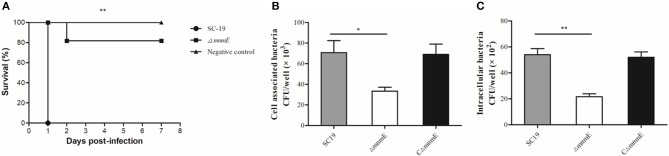
MnmE contributes to SS2 pathogenicity in vivo and in vitro. (A) Survival curves for mice in experiment infection. Ten mice in each group were separately injected intraperitoneally with 3 × 109 CFU/mice of SC19 and ΔmnmE. Ten mice were inoculated with saline and served as negative control. Significant difference in survival between different groups were analyzed by Log Rank test (p < 0.01). (B) Cell-associated bacteria recovered after incubation with HEp-2 cells. The mutant strain ΔmnmE showed significantly reduced levels of adherence to HEp-2 cells compared with the degree of adherence of SC19 and CΔmnmE (p < 0.05). (C) Bacteria invasion of HEp-2 cells. The mutant strain ΔmnmE showed significantly reduced levels of invasion of HEp-2 cells compared with that of SC19 and CΔmnmE (p < 0.01). Statistical significance was determined by two-tailed t-test (*p < 0.05; **p < 0.01).